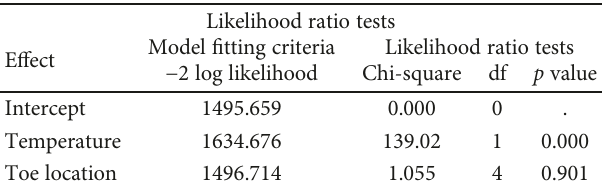
Table 2: Likelihood ratio tests (model